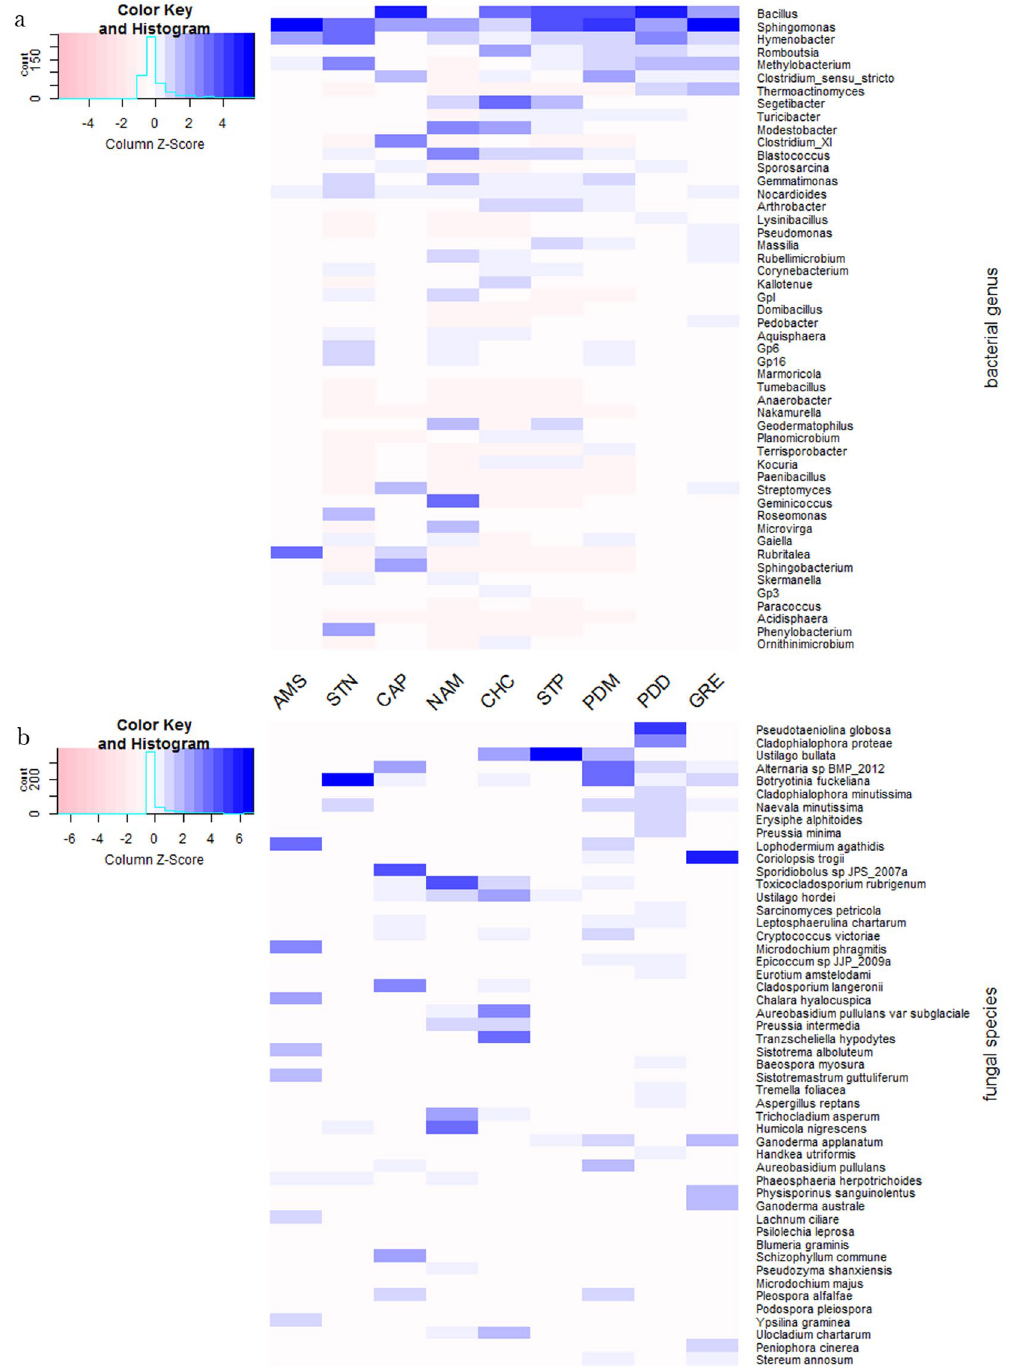
Figure 2. Heatmaps of the relative abundances (the relative abundances are centered and scaled) of the fifty most abundant bacterial genera ( a ) and fungal species ( b ) in the dataset. The fifty bacterial genera and fungal species are in order of decreasing relative abundance from top to